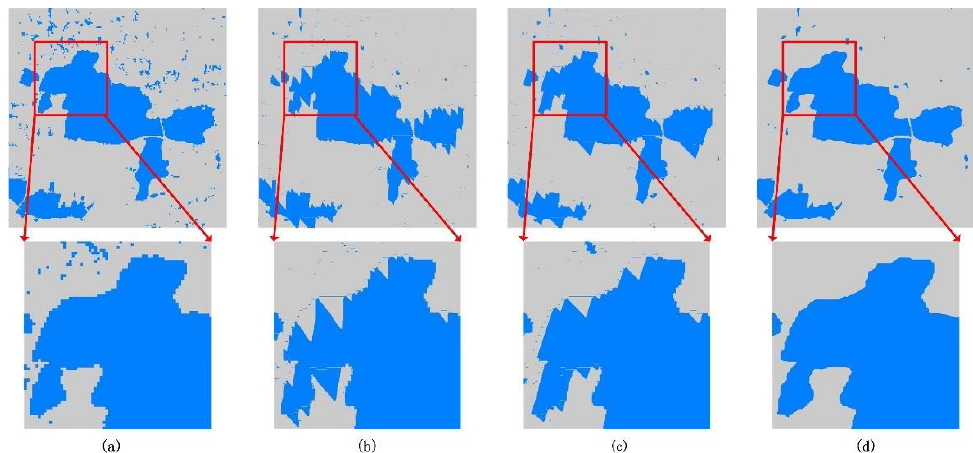
Figure 5. Resultant water body maps for small lakes generated by MESMA_MST_SRM with different weighting coefficients: ( a ) α = 0, β = 10; ( b ) α = 10,000, β = 0; ( c ) α = 8000, β = 100; ( d ) α = 8000, β = 2500.